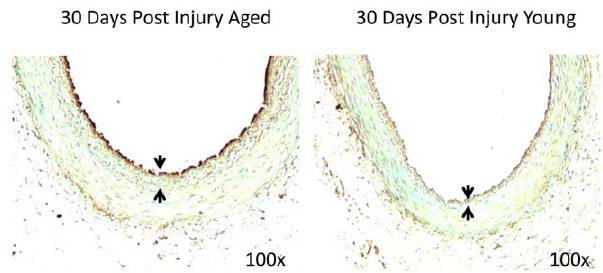
Figure 6. Myl9 immunostatining of old (22 months) and young (3 months) injured rat iliac arteries. Shown are representative images of young and old iliac arteries 30 days post injury, immunostained for Myl9. Results confirm over-expression of Myl9 in the older injured group and point to concentration of Myl9 expression in the endothelial layer of the iliac arteries during this post injury period.